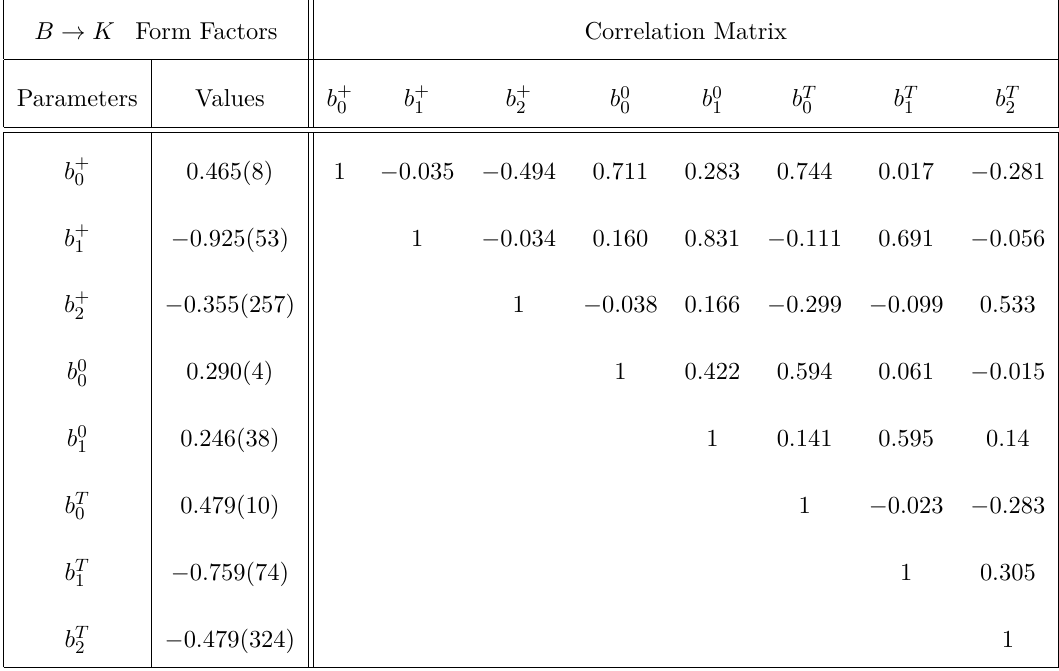
Table 3 . Theory predictions for the correlated z -series coefficients in the vector, scalar and tensor B → K form factors determined by fitting the BGL parametrization simultaneously against our LCSR results including a variety of the subleading-power corrections and the available lattice QCD data points from [14, 15] with the preferred truncation N = 3